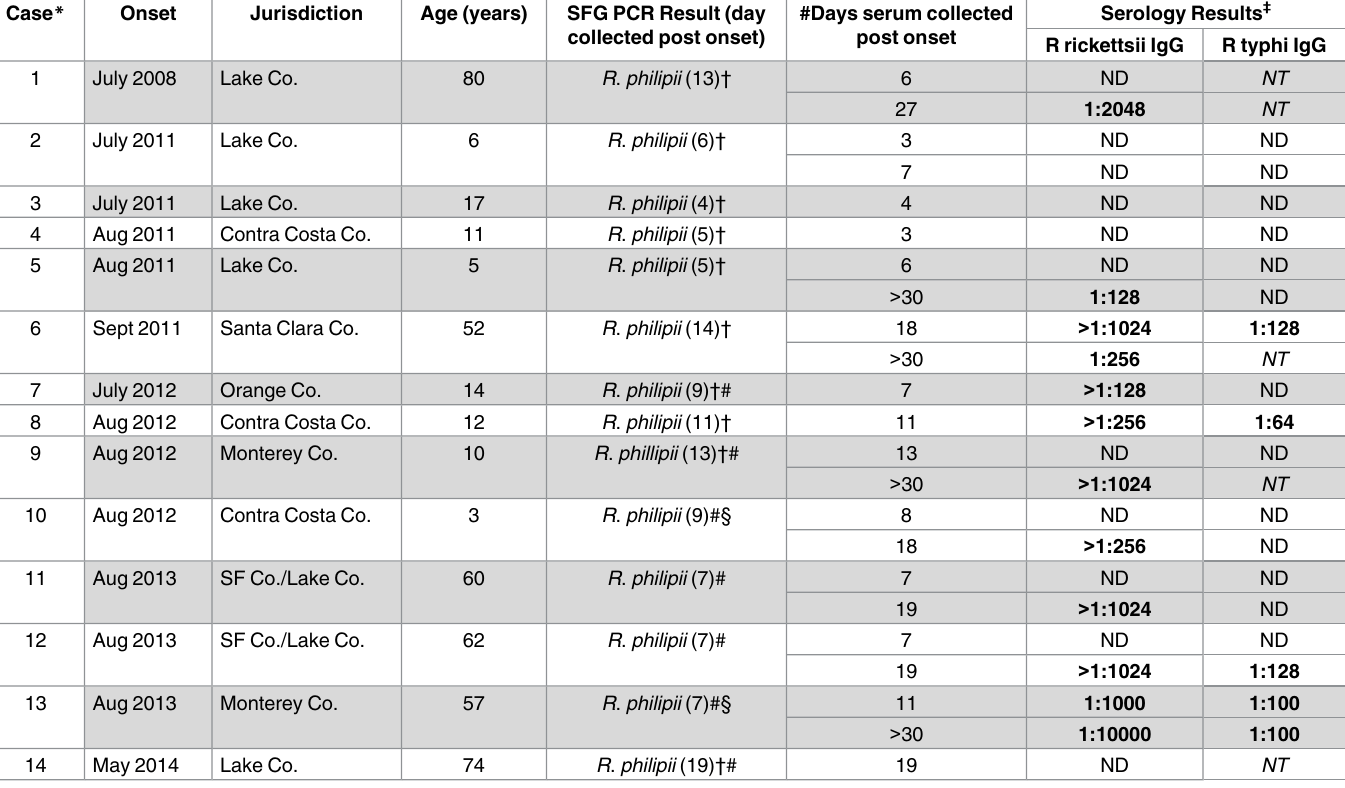
Table 2. Serological results from all human Pacific Coast tick fever case patients, California,